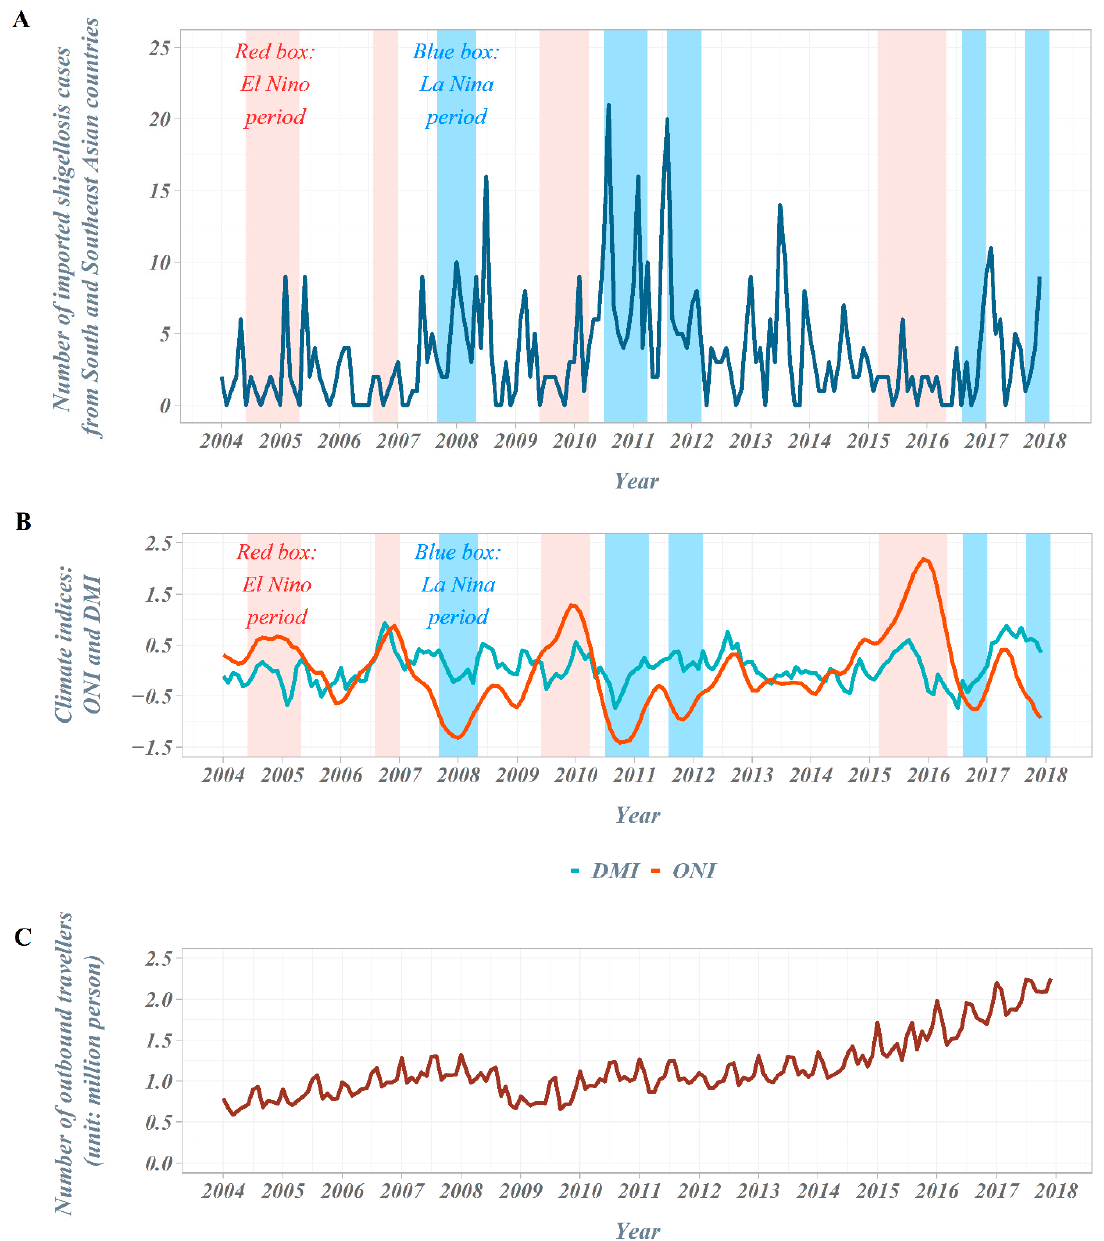
Figure 2. Time trends in the Republic of Korea, 2004–2017. ( A ) Number of imported shigellosis cases from South and Southeast Asian countries, 2004–2017; ( B ) time trends of climate indices: ONI and DMI, 2004–2017; ( C ) number of outbound travelers in the Republic of Korea, 2004–2017. Table 1. Distribution of imported cases of shigellosis across travel destinations, 2004–2017.